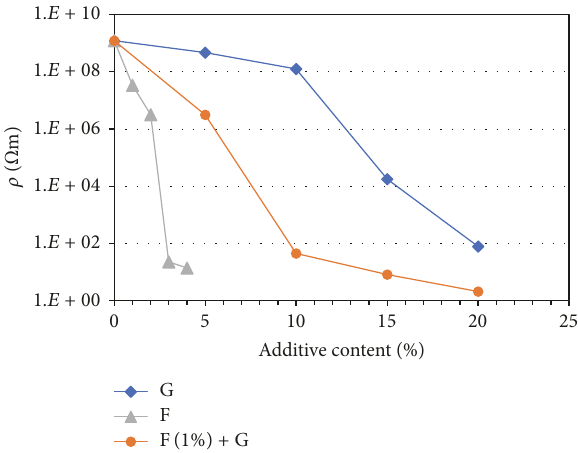
Figure 5: Average electrical resistivity result.